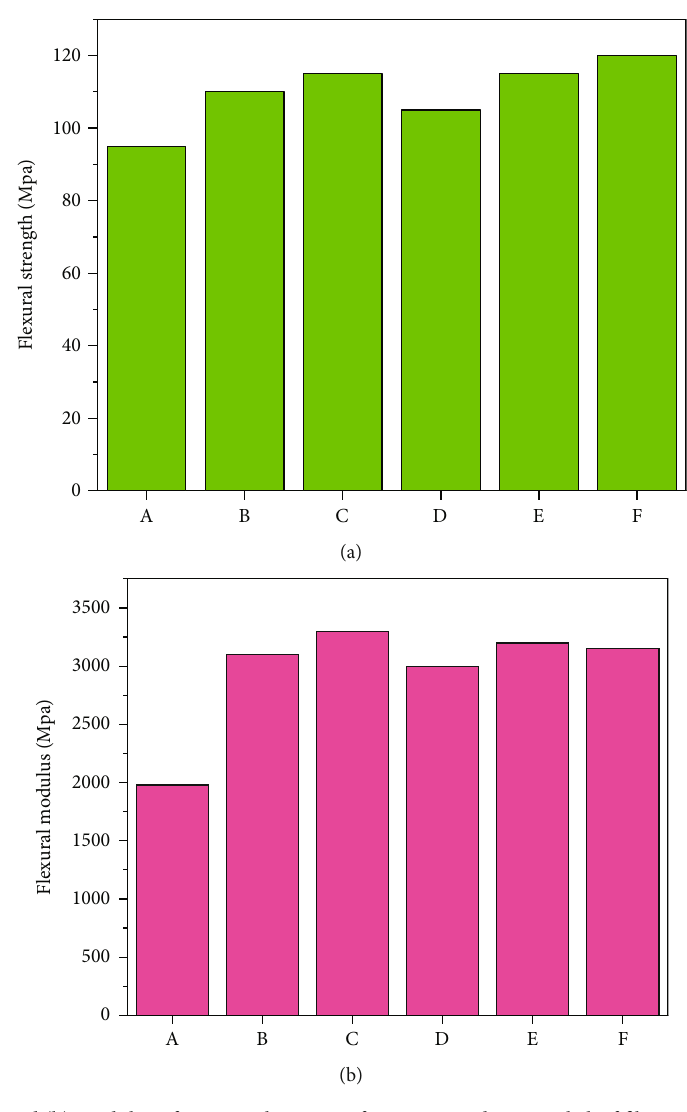
Figure 3: (a) Flexural strength and (b) modulus of neat vinyl ester reinforcement and pineapple leaf fi bers reinforced vinyl ester